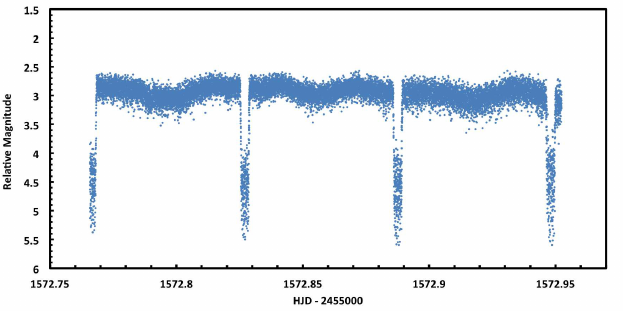
Figure 7: V-band photometry obtained during a low accretion state of FL Ceti.